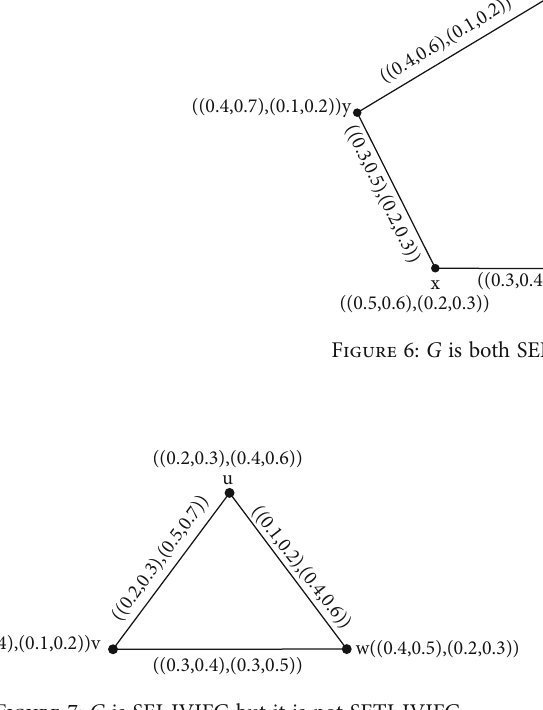
Figure 7: G is SEI-IVIFG but it is not